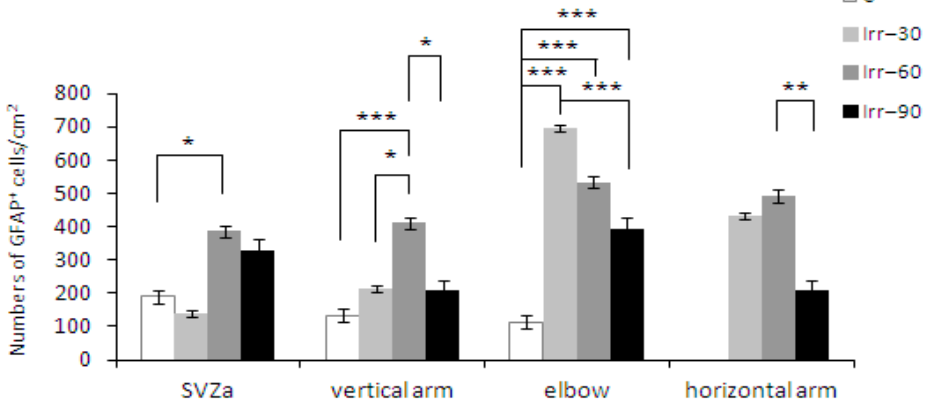
Figure 3. Distribution of astrocytes in individual parts along the SVZ-OB axis in the forebrain of control animals and rats, survived 30, 60 and 90 days after fractionated radiation treatment with a total dose of 4 Gy (C, Irr-30, Irr-60, Irr-90; x ± SEM). Statistical significance of differences between control and irradiated groups and between the irradiated animals: * p ≤ 0.05; ** p ≤ 0.01; *** p ≤ 0.001.